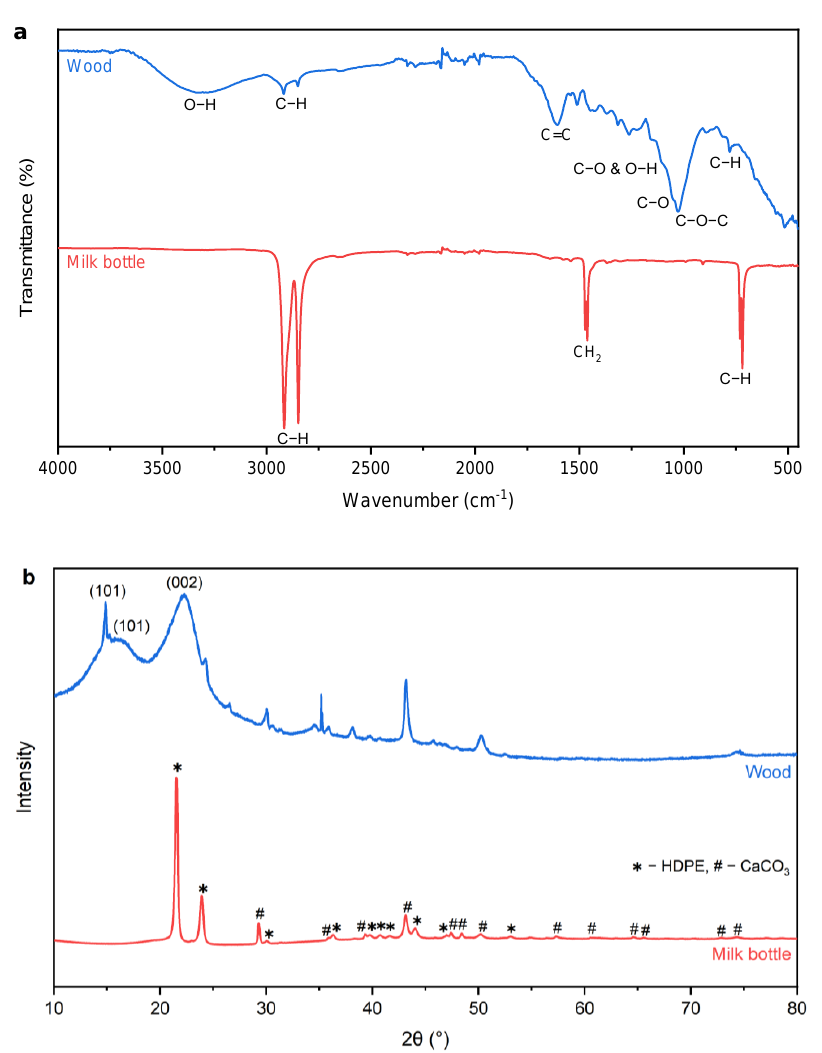
Figure 2. ( a ) Fourier transform infrared spectroscopy (FTIR) and ( b ) X-ray diffraction (XRD) of raw materials used in this study. Table 1 . The prepared injection-molded samples in this study.